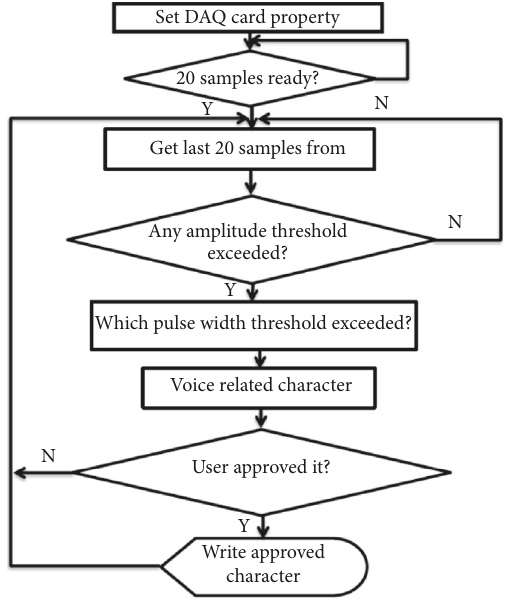
Figure 5: General flow chart of the developed software.